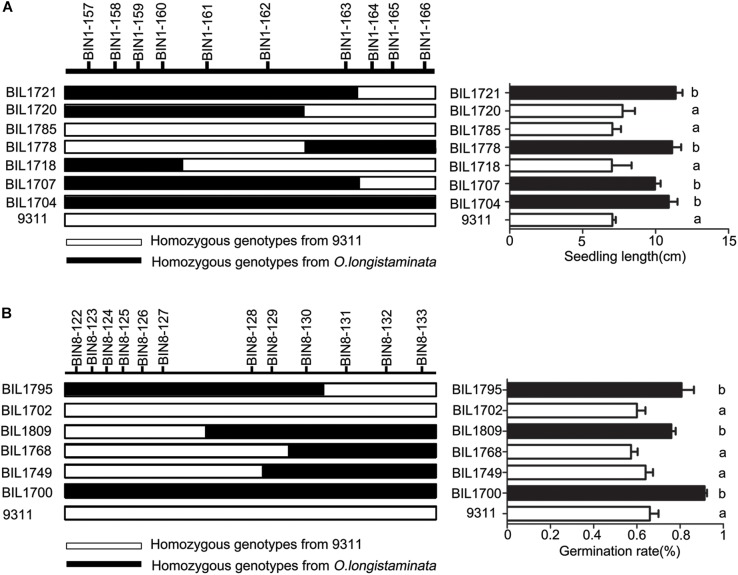
Confirmation of the position of QTLs q9SL1.1 and q9GR8.1. (A) Verification of the q9SL1.1 using 8 BIL lines to delimit it to an interval between molecular marker Bin1-162 and Bin1-163. Black rectangle indicates the homozygous from O. longistaminata, white rectangle shows the homozygous from parent 9311, gray indicates the heterozygote genotype. (B) Verification of the q9GR8.1 using 7 BIL lines to delimit it to an interval between molecular marker Bin8-127 and Bin8-128.